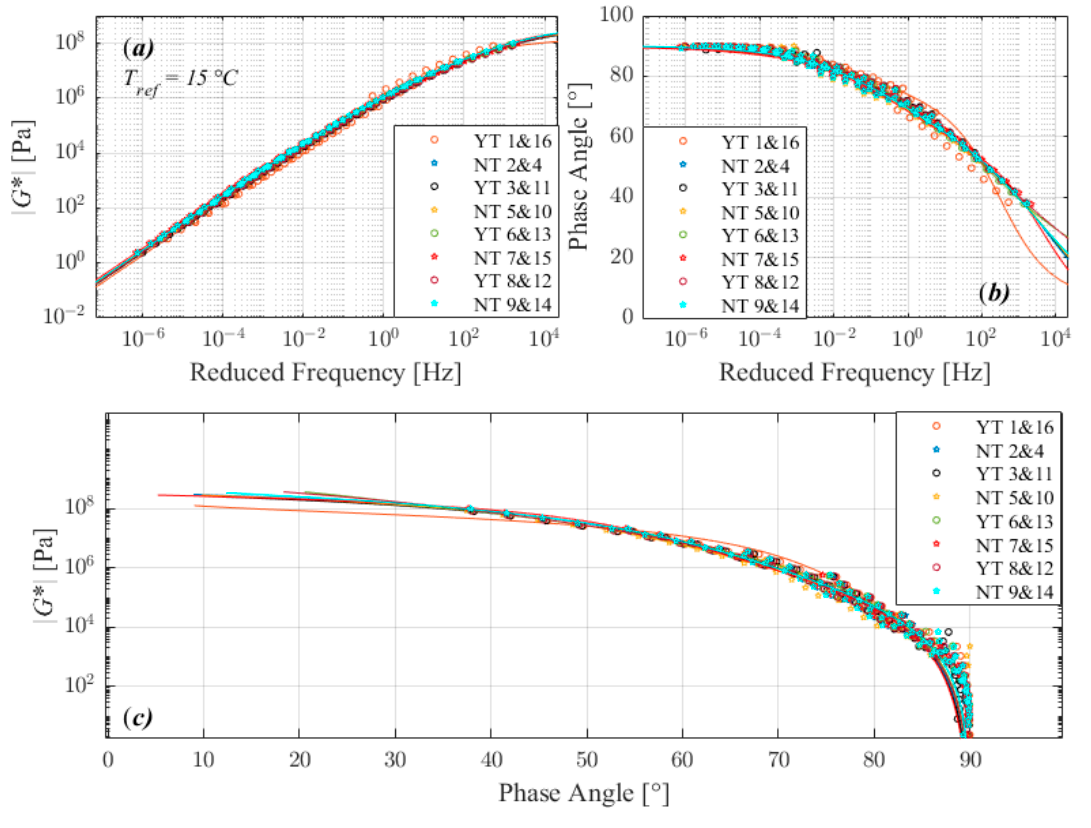
Figure 6. Comparison of master curves of complex shear modulus ( a ), phase angle ( b ), and black diagram ( c ) for 160/220_II.